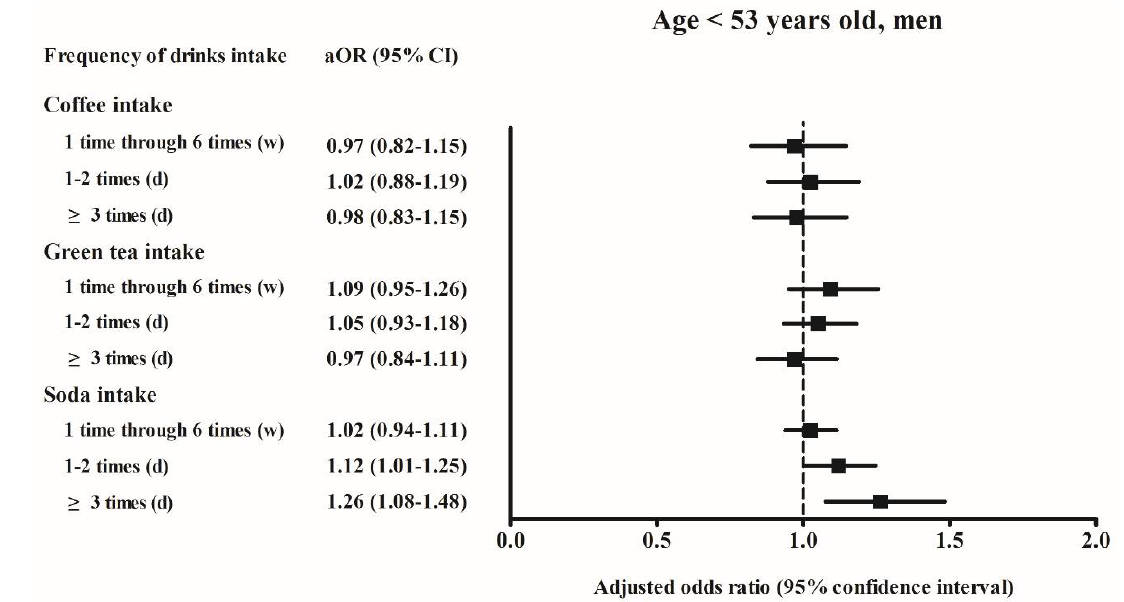
Figure 3. The adjusted odds ratio of the hyperuricemia according to the frequency of coffee/green tea/soda (soft drink) intake in the age ≥ 53 years old women. Fully-adjusted model (age, BMI, income, past medical histories, smoking, alcohol consumption, nutritional intake, frequency of coffee, green tea, and soft drink intake) was used.